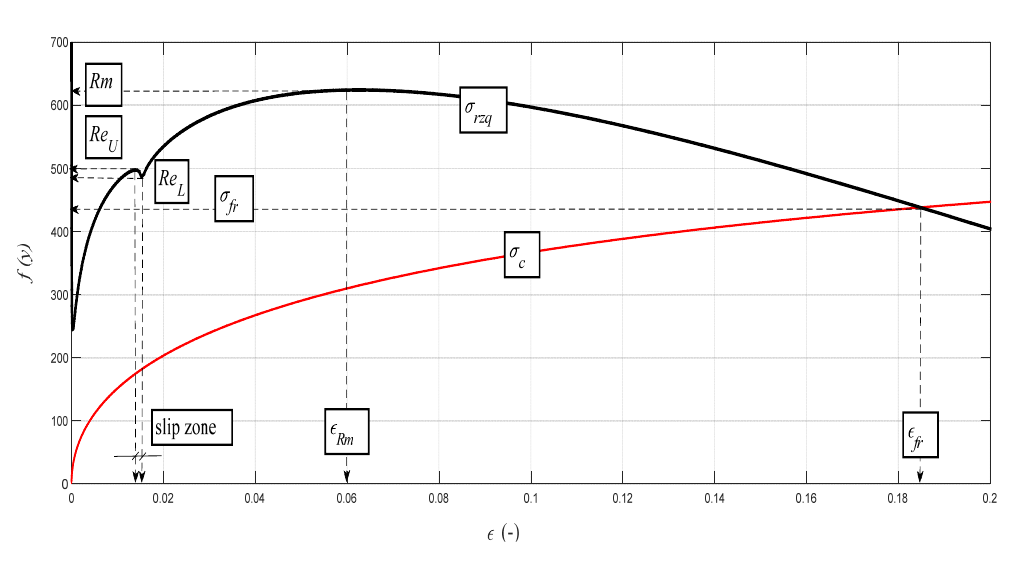
Figure 10. Analytical deformability diagram for the steel grade S355J0 for the dependence σ rzq = f ( ε ); detail for Re U and Re L . σ rzq (black color) and σ c (red color).